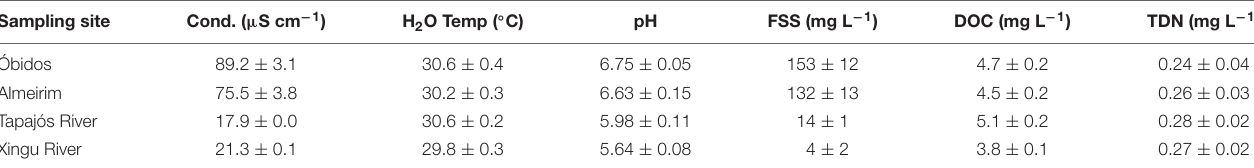
TABLE 1 | Initial conductivity (cond), water temperature, pH, fine suspended sediments (FSS), dissolved organic carbon (DOC), and total dissolved nitrogen (TDN) at each sampling